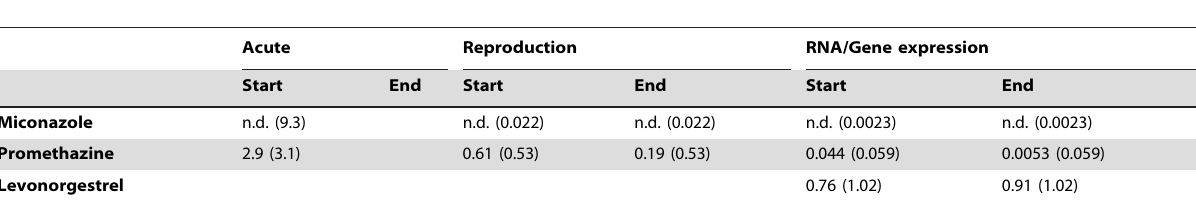
Table 3. Measured concentrations (mg L 2 1 ) in the aqueous phase of the test medium before (Start) and after (End) exposures.